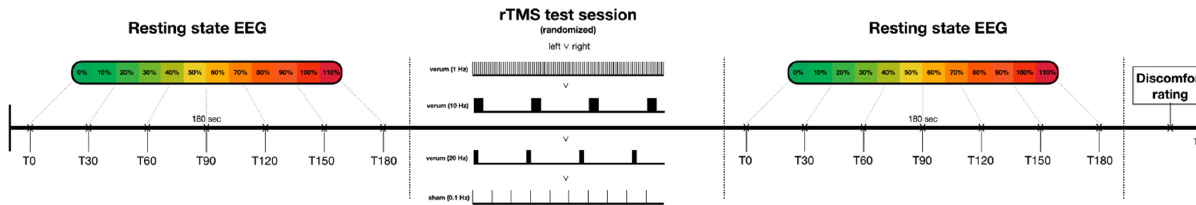
Figure 1. Test session procedure. Test sessions were conducted on two different days according to the same procedure. Three different verum rTMS protocols (1, 10, 20 Hz) with 200 pulses each and one sham protocol (0.1 Hz) with 20 pulses were administered over the left and right temporo-parietal junction in a randomized order. Thus, a total of 8 different rTMS protocols were applied on each test session day. Before and after each magnetic stimulation, participants were requested to rate the subjective loudness of their tinnitus on a numeric rating scale from 0% to 110% (0%—complete absence of tinnitus; 100%—no change; 110%—10% loudness increase) at seven points in time (30 s inter-rating interval). In parallel to these ratings, resting state brain activity was recorded with electroencephalography (EEG) for three minutes. At the end of each rTMS protocol (pre-rating/recording–stimulation–post-rating/recording), patients had to rate the induced level of discomfort on a numeric rating scale from 0 to 10 (10—utmost discomfort).